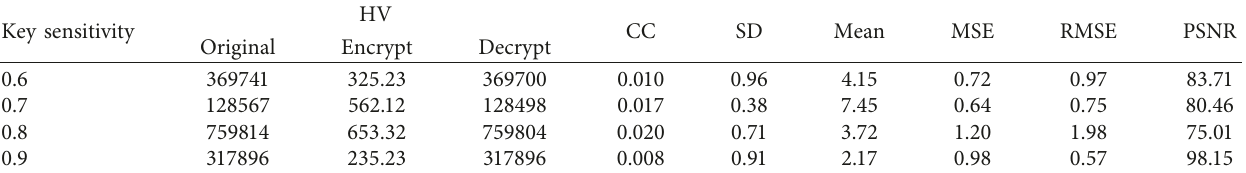
Table 7: Performance of original and encrypted image for all